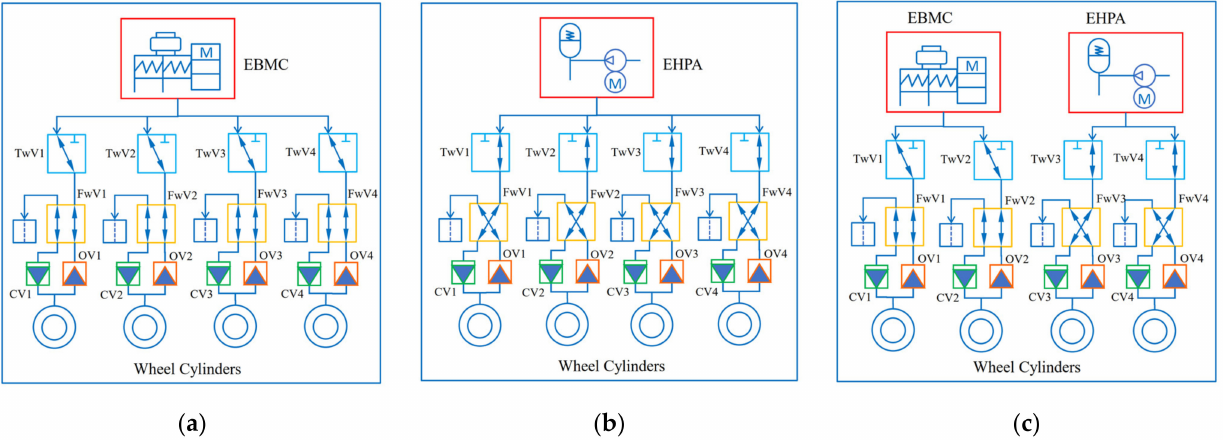
Figure 2. Normal initiative braking modes. ( a ) Braking with a sole EBMC as the hydraulic power source; ( b ) Braking with a sole EHPA as the hydraulic power source; ( c ) Braking with both an EBMC and an EHPA as the hydraulic power